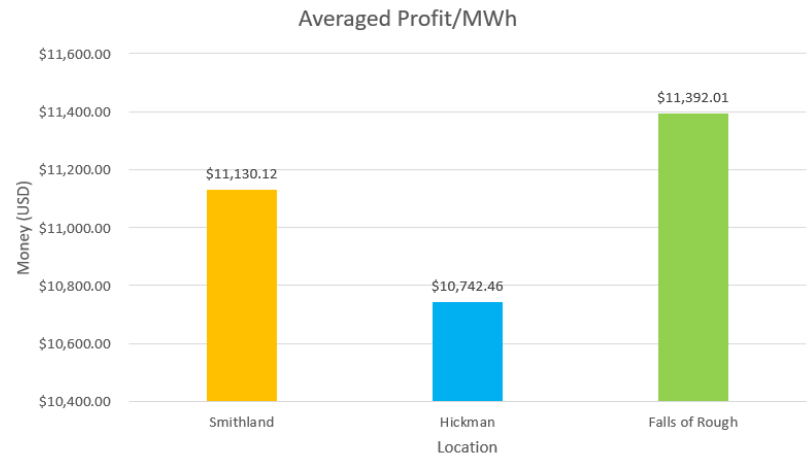
Figure 23. Price per MWh Estimates Figure 23 . Price per MWh Estimates [27–29].